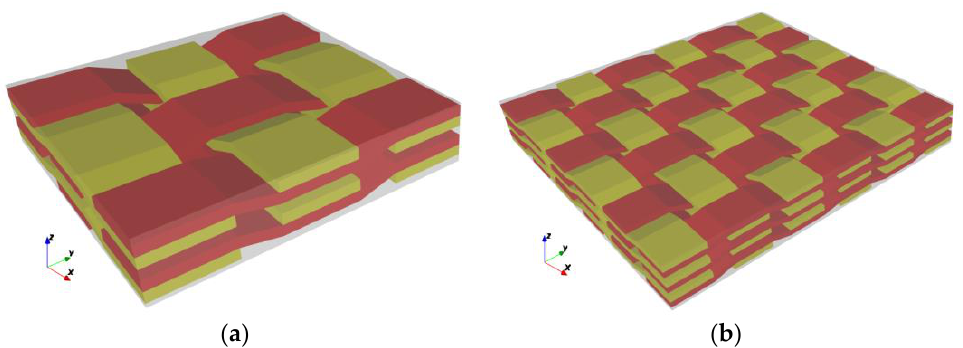
Figure 4. The parametric model of weave composite. ( a ) 3 × 3 × 2 geometric model, ( b ) 6 × 6 × 3 geometric model.